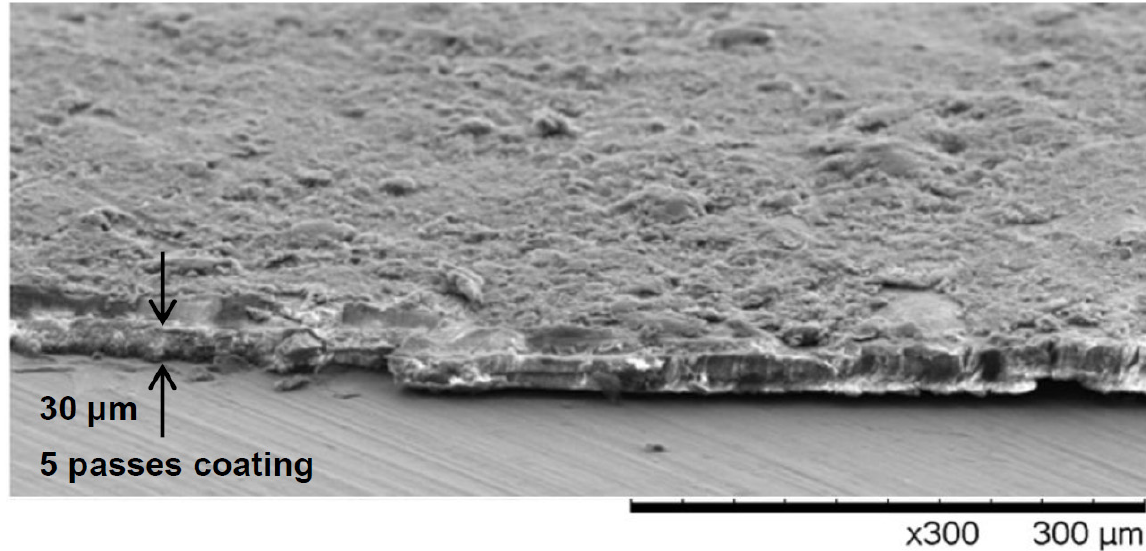
Figure 1. Scanning electron microscopy (SEM) image of temperature-sensitive paint (TSP) layer on molybdenum substrate after a layer fragment separation for microscopic structure inspection.